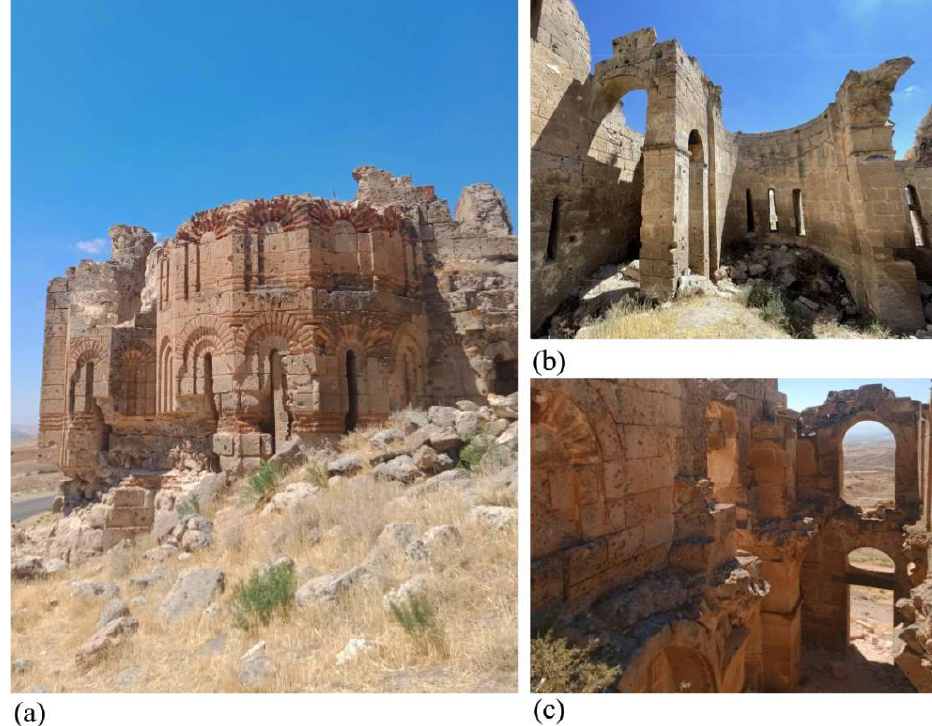
Figure 2. ( a ) An exterior view of Bell Church; ( b ) an interior view of the main church space (naos) with three apses; ( c ) the entrance hallway (narthex) of the church.